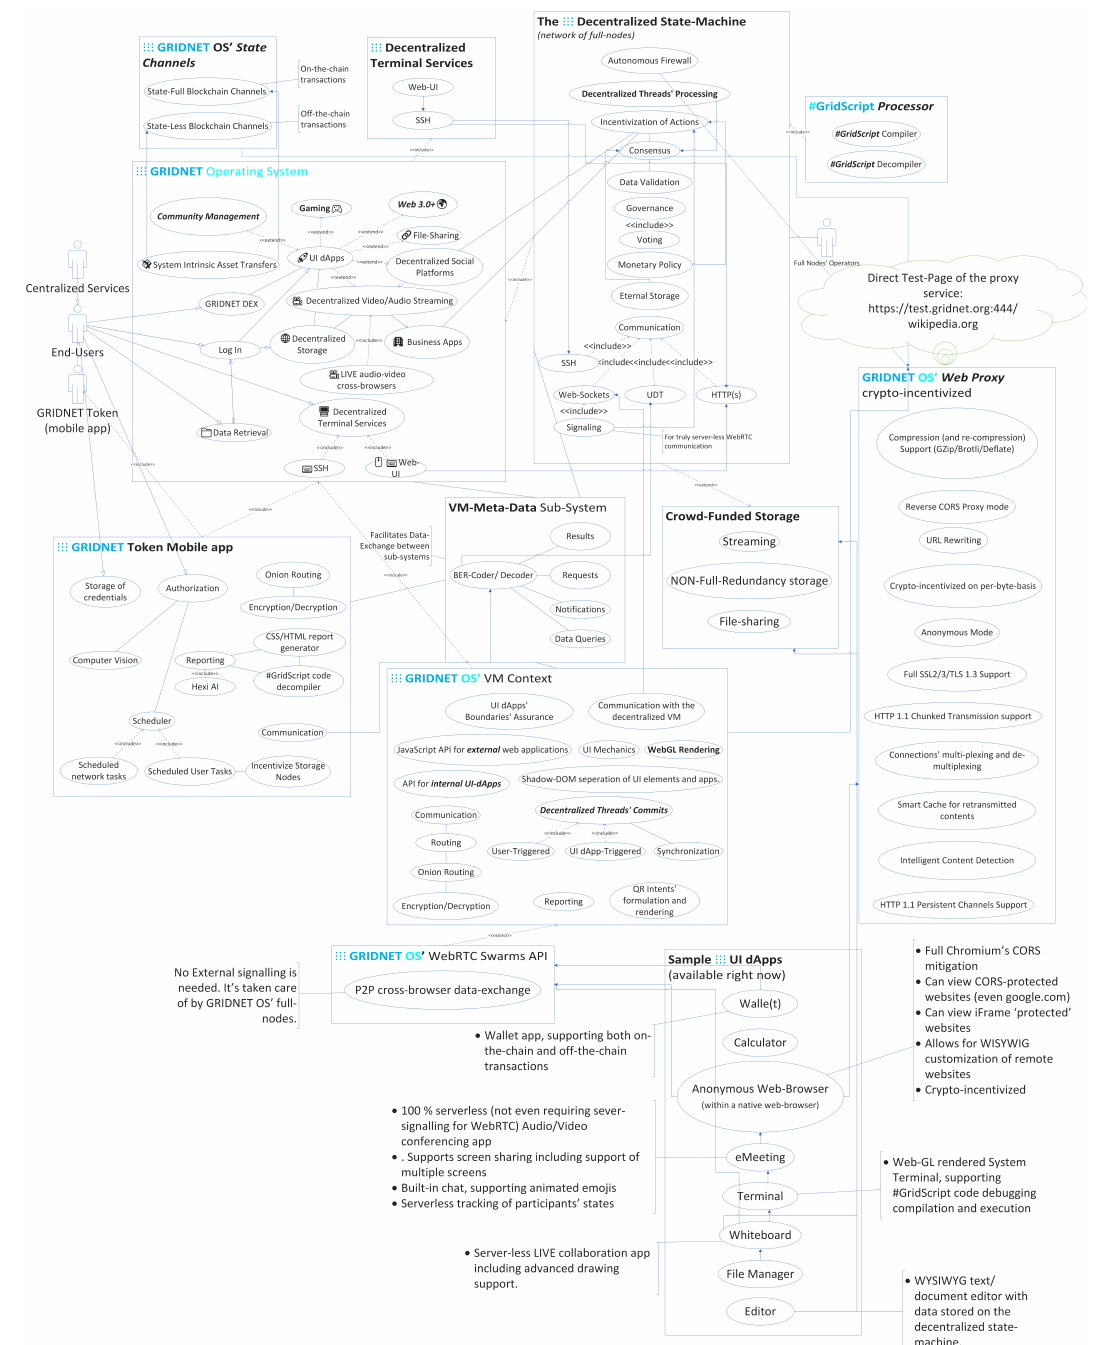
Figure 2. Simplified version of a hybrid UML use-case